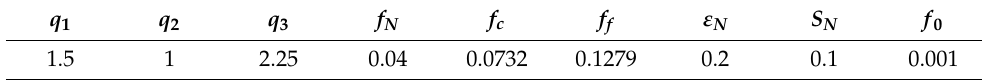
Table 3. Parameters for GTN